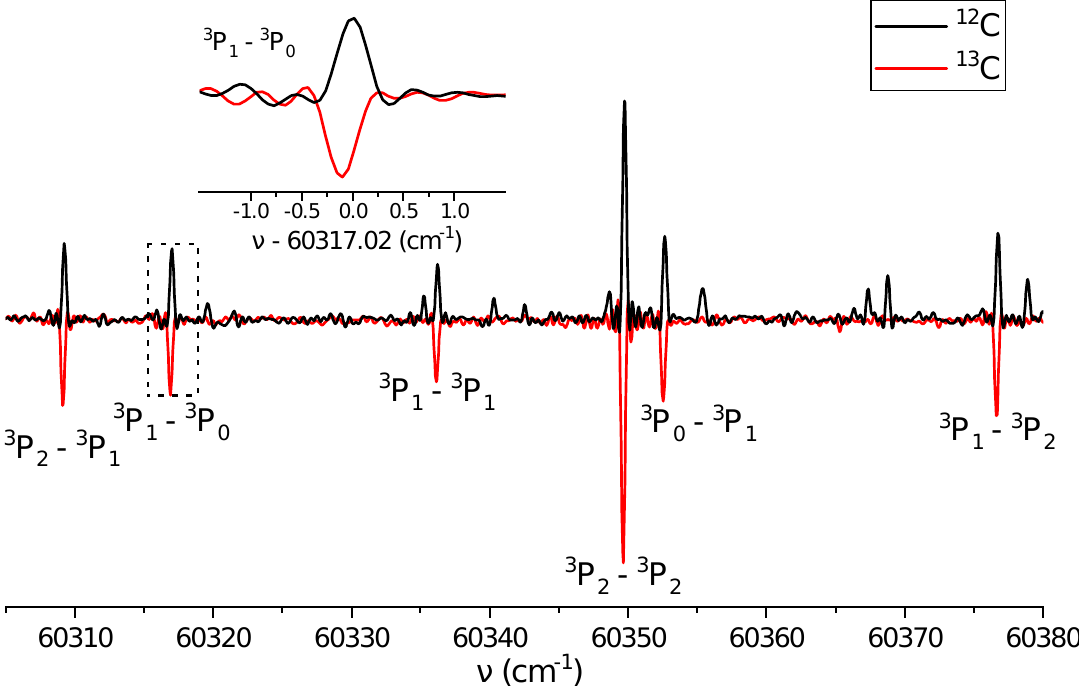
Figure 4. Overview spectra of the C I 3 P J – 3 s 3 P J multiplet recorded in absorption. The inset shows the 3 P 1 – 3 s 3 P 0 transition. The 12 C spectrum is partly overlapped with lines from the A-X (2, 0) band of 12 C 16